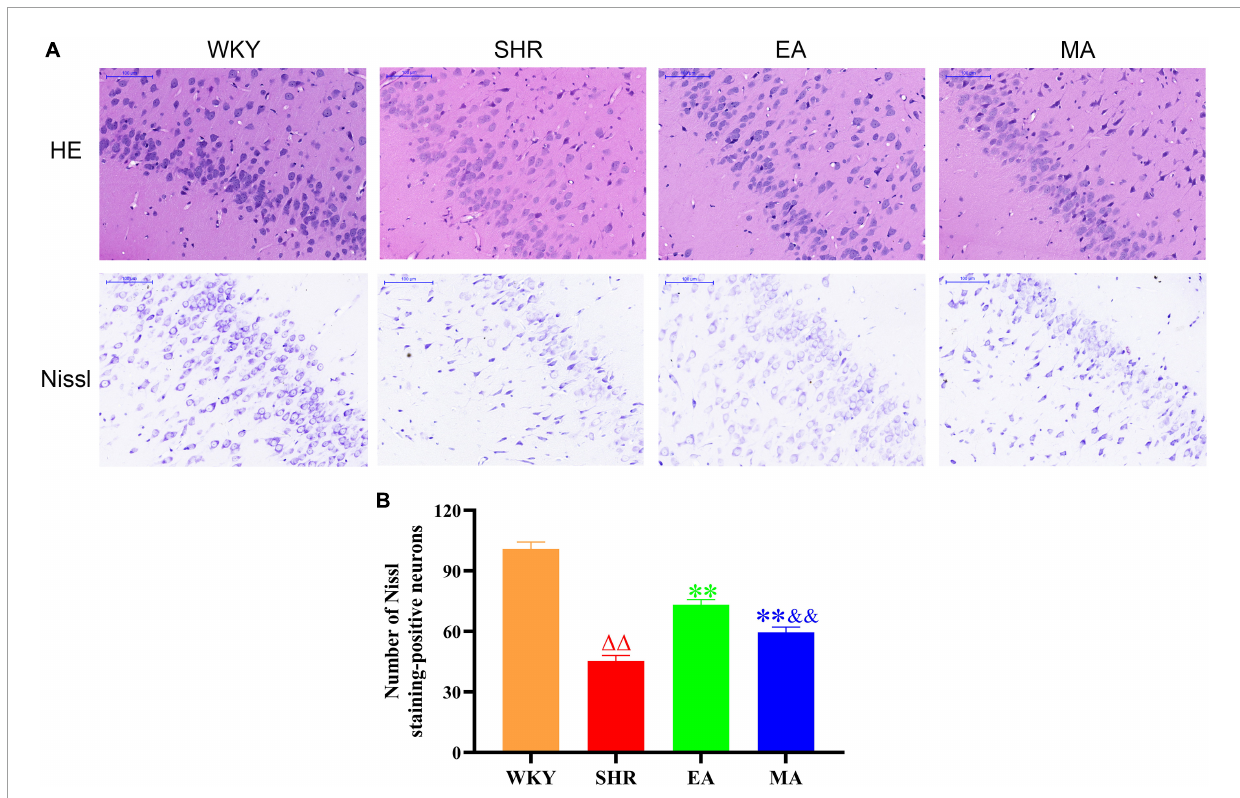
FIGURE5 Electroacupuncture and manual acupuncture ameliorate neuronal injury in entorhinal cortex in spontaneously hypertensive rats (SHRs). The results of HE staining and Nissl staining in the entorhinal cortex. (A) Representative images of HE staining and Nissl staining in the entorhinal cortex of the Wistar–Kyoto (WKY), SHR, EA, and MA groups. Scale bar = 100 µ m. (B) Quantitative evaluation of Nissl staining-positive neurons. Scale bar = 100 µ m. The values are expressed as the means ± SEM ( n = 3 rats/group). (cid:49)(cid:49) p < 0.01 vs. WKY group; ∗∗ p < 0.01 vs. SHR group; && p < 0.01 vs. EA group. WKY, normal control group; SHR, model group; EA, electroacupuncture group; MA, manual acupuncture